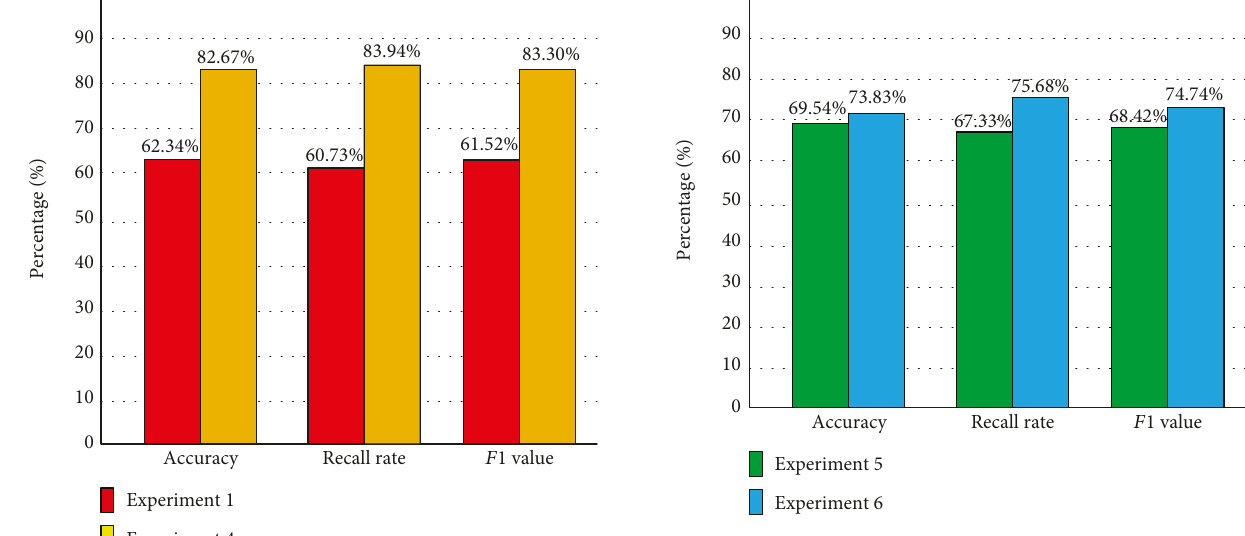
Figure 6: Comparison of Experiment 5 and Experiment 6.